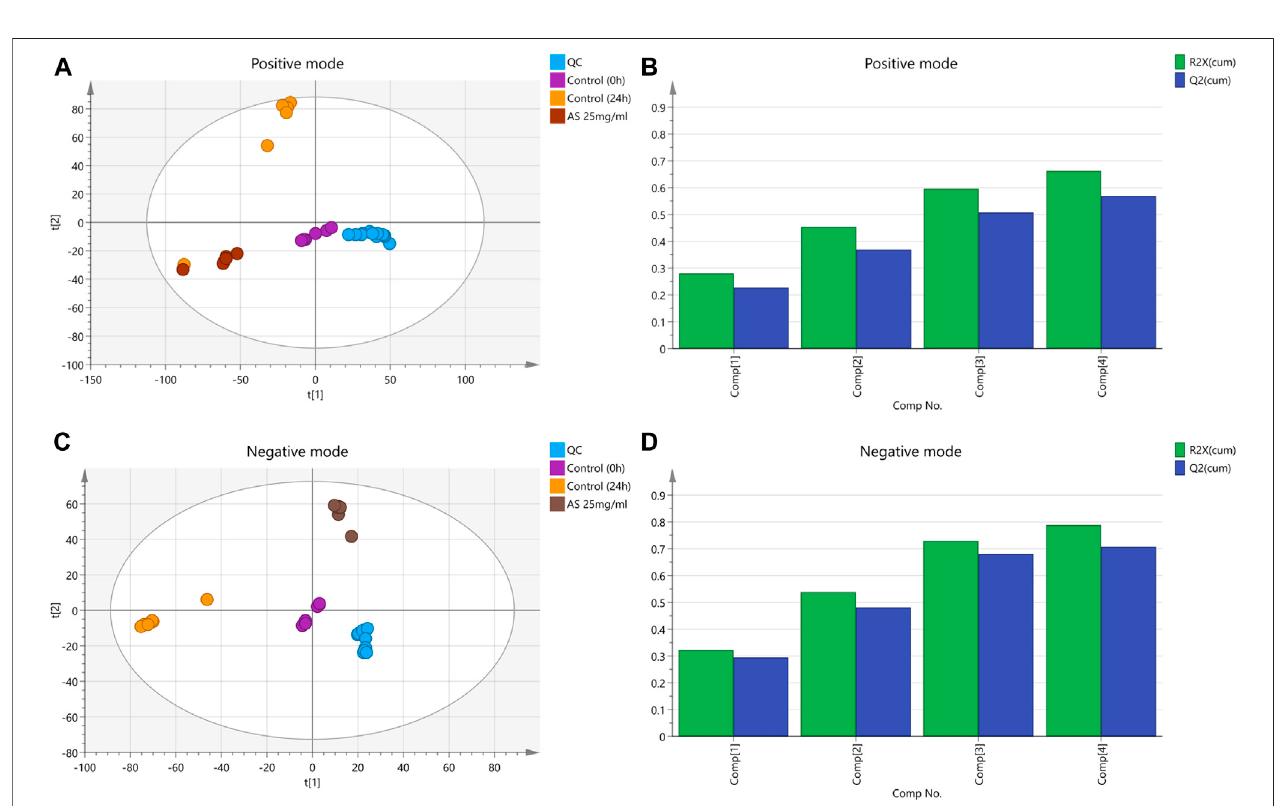
FIGURE 6 | PCA score plots based on the MRSA endogenous metabolic spectra obtained in the positive and negative ion mode. (A and C) PCA score plots; QC: quality control. (B) R2X (cid:1) 0.663 cum, Q2 (cid:1) 0.569 cum. (D) R2X (cid:1) 0.788 cum, Q2 (cid:1) 0.707 cum.